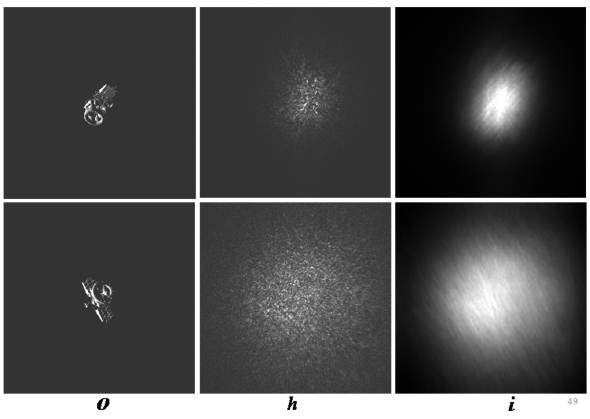
Figure 9. AES image convolution and atmosphere point-spread function